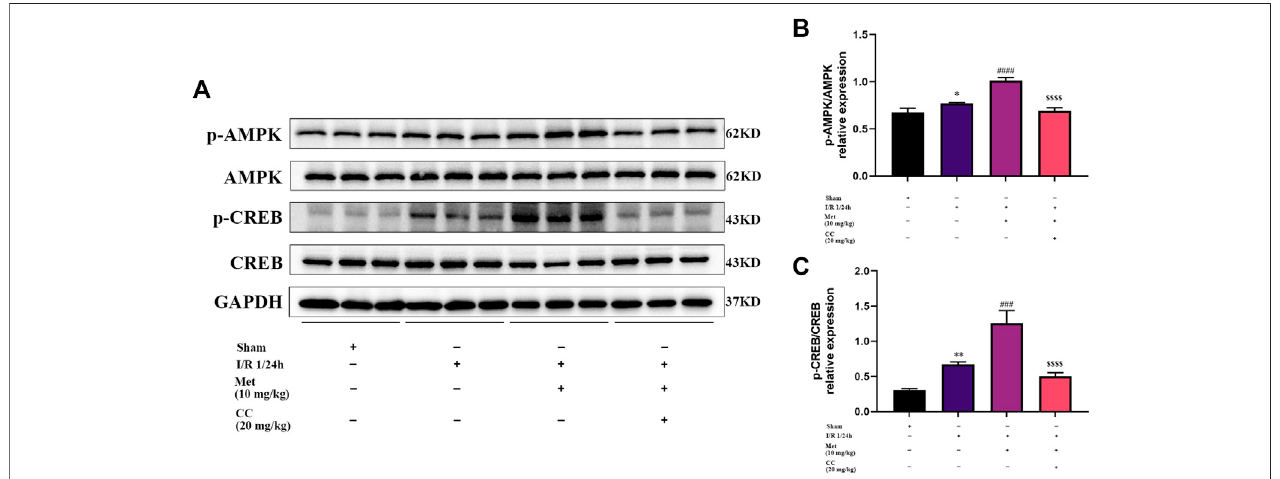
FIGURE 4 | AMPK and CREB are involved in the regulation of BDNF expression by metformin in cerebral ischemia-reperfusion (I/R) injury. (A – C) The phosphorylationlevelsofAMPKandCREBproteinswasdetectedbywesternblotting( n =3).(* p < 0.05,** p < 0.01vs.sham; ### p < 0.001, #### p < 0.0001vs.I/R1/24